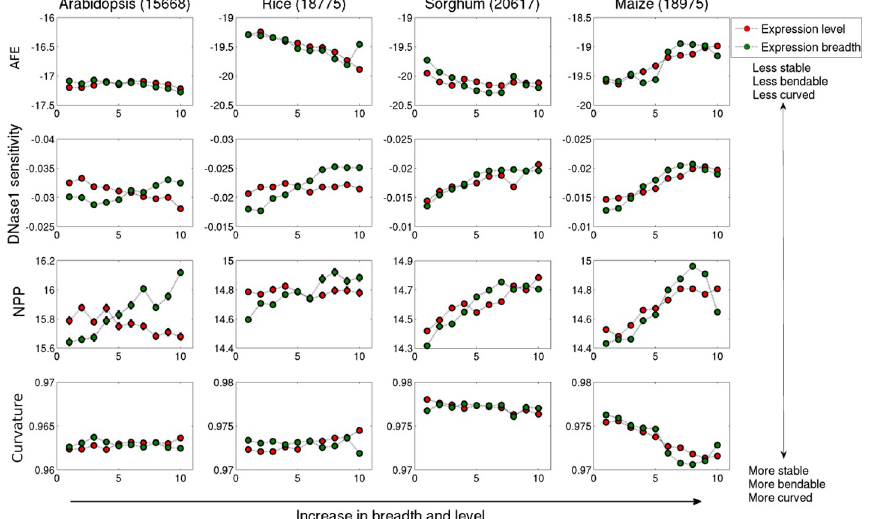
Fig 5. Structural feature parameter values for the promoter regions (-200 to 0) of arabidopsis, rice sorghum and maize. The averaged value of each 10 percentile bin for AFE, DNase 1 sensitivity, NPP and curvature are plotted. Genes were sorted based on the average expression value and split into 10 equal bins, where each bin contains 10% of the data. The bins are numbered 1 to 10 with increasing value of expression level and breadth.